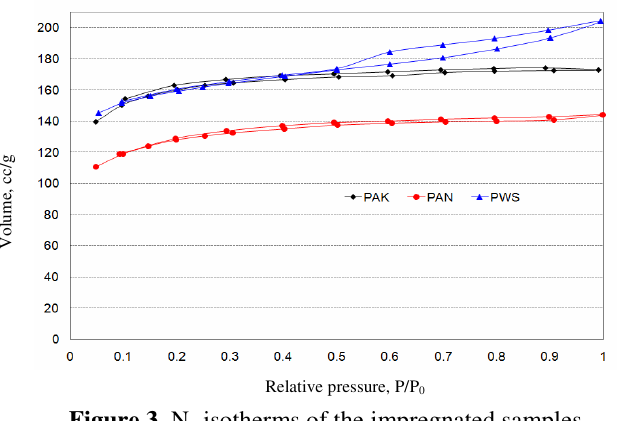
Figure 3. N isotherms of the impregnated samples 2